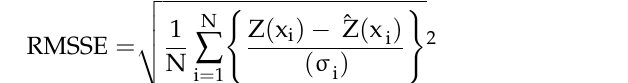
Table 1. Summary of descriptive statistics of annual THI values.